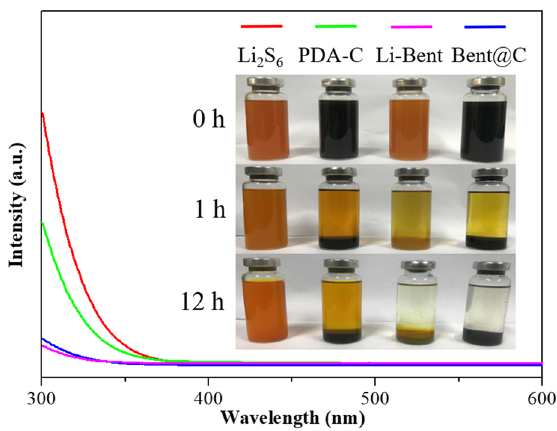
Figure 5: UV - vis spectra ( 300 – 600 nm ) of the Li 2 S 6 solution after exposure to PDA - C, Li - Bent, and Bent@C, respectively, for 12 h. The inset images show the color changes of the Li 2 S 6 solution during exposure to di ff erent sorbent materials.